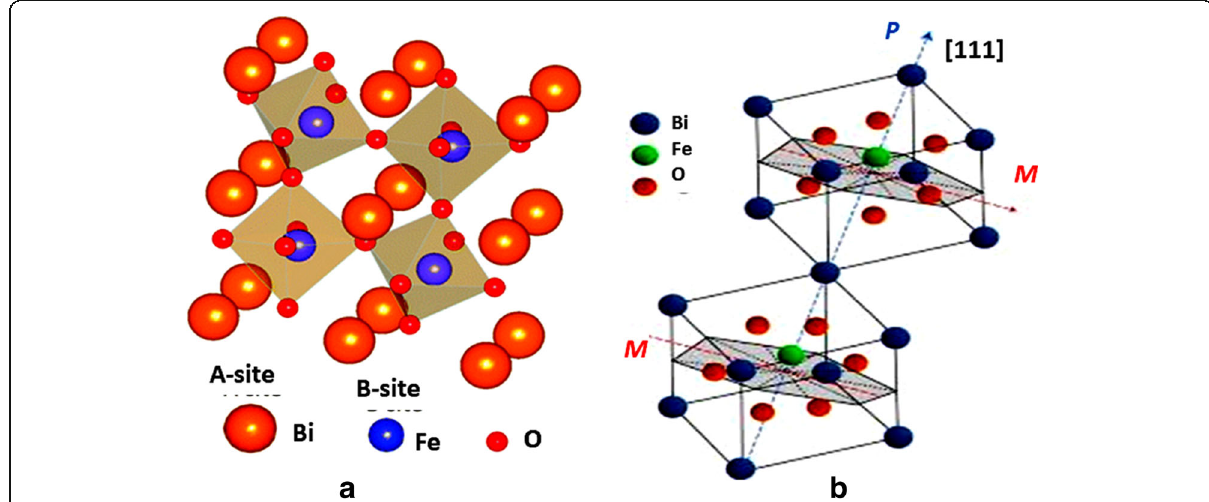
Fig. 4 a The perovskite crystal structure of BiFeO 3 adapted from Seidel et al. [28]. b Distorted perovskite structure adapted from Ederer and Spaldin